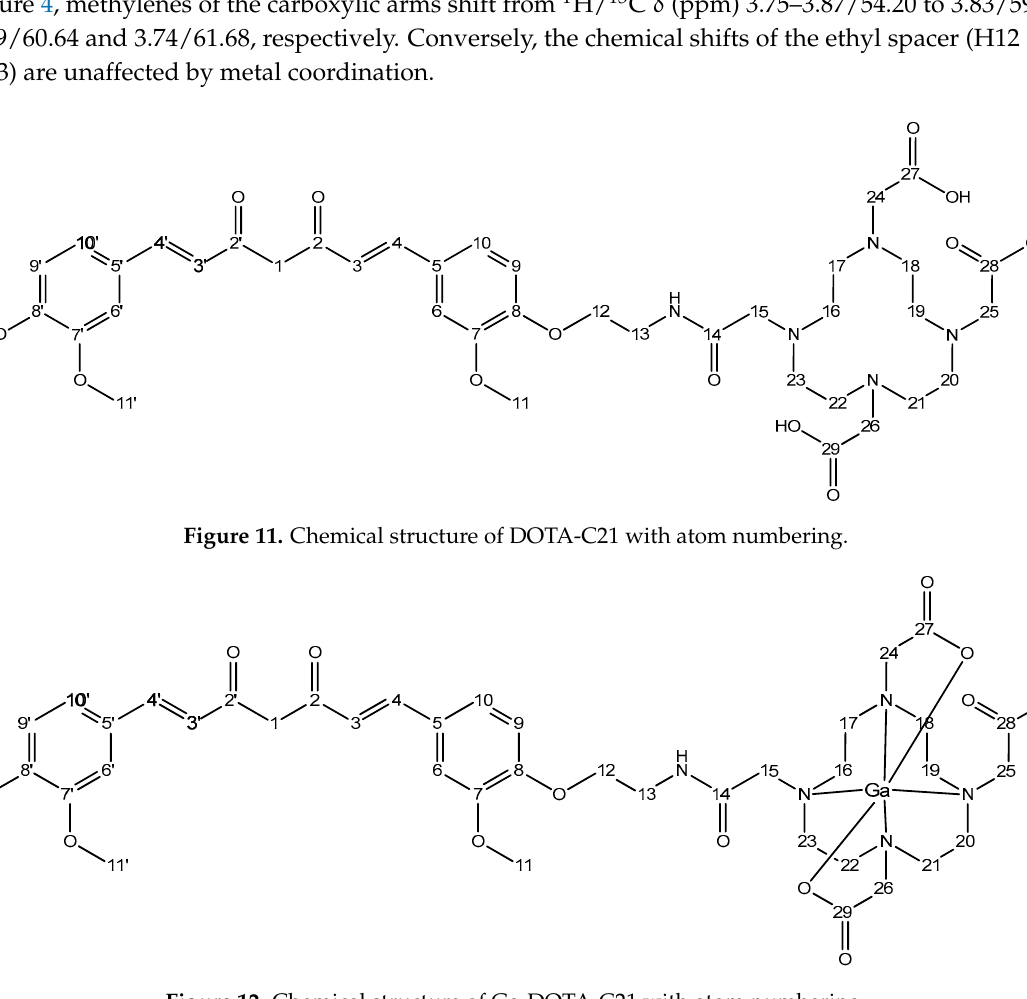
Figure 12. Chemical structure of Ga-DOTA-C21 with atom numbering.